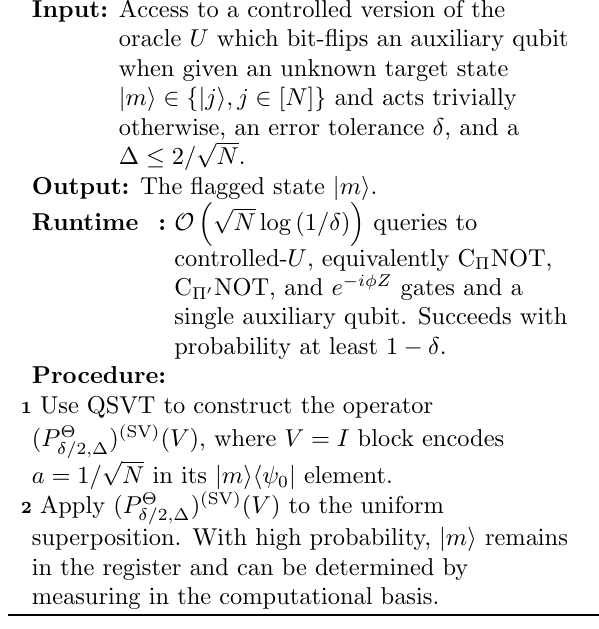
Algorithm 1. Unstructured Search by